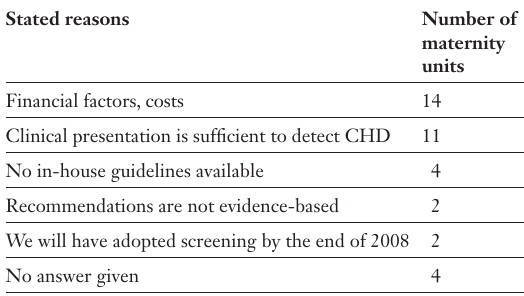
Reasons for not per- forming pulse oxime- try (PO) screening. Answers given by the 33 out of 136 mater- nity units who do not perform PO screen- ing. Multiple answers